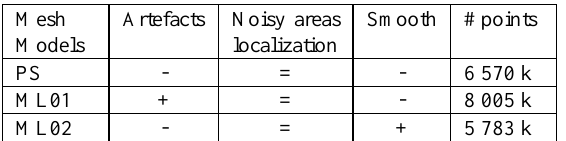
Table 6. Assessment of surface models meshed using Photoscan (PS) and Meshlab (ML01 and ML02)